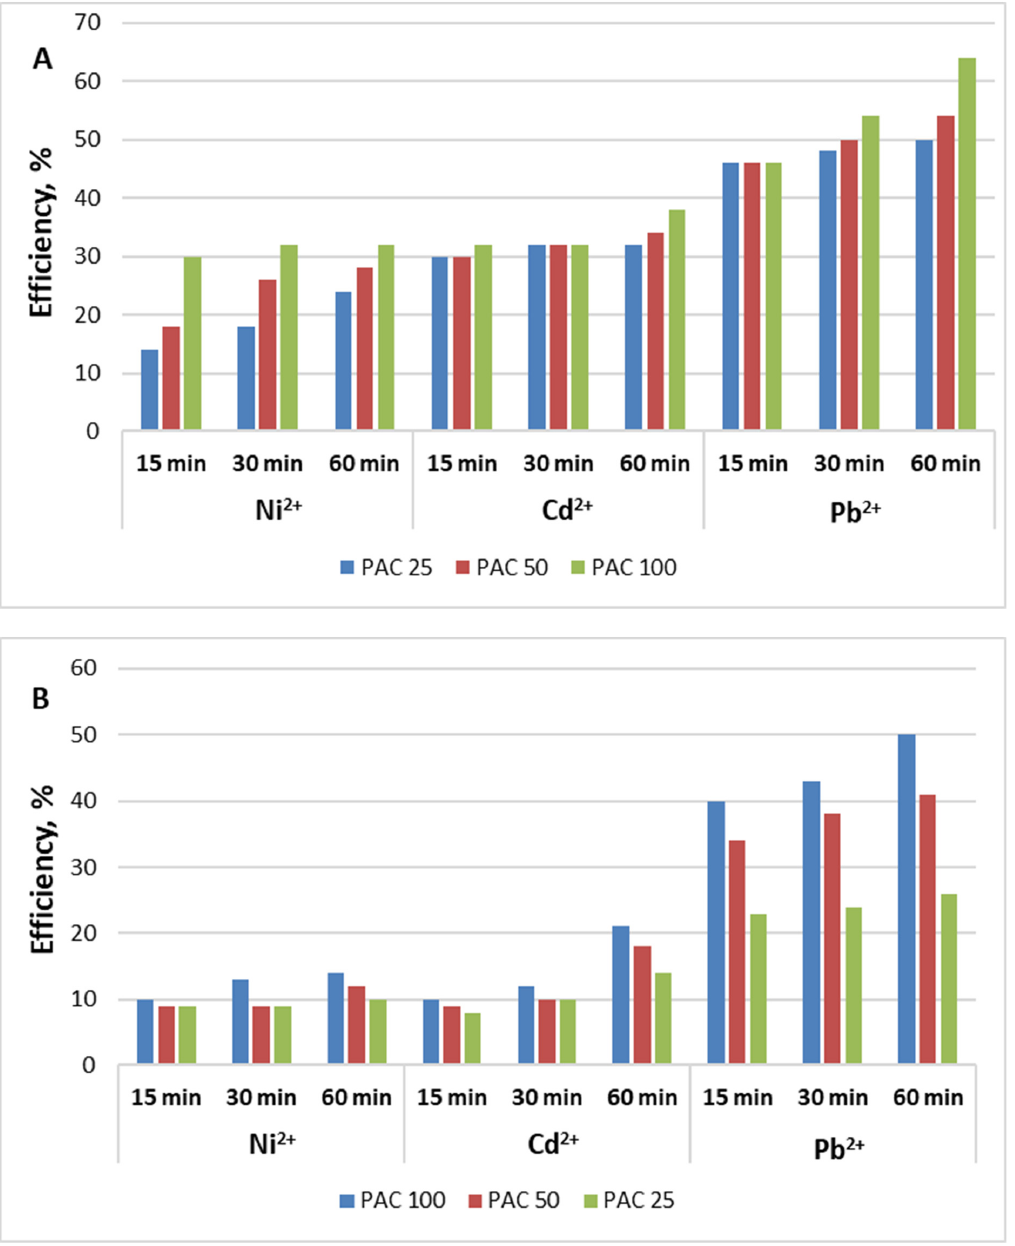
Figure 3. Efficiency of analysed metal ions removal from model water in the adsorption process with using powdered activated carbon (dose: 25, 50 and 100 mg/L), time of process 15, 30 and 60 min, initial concentration of heavy metal ions: ( A ) 0.5 mg/L and ( B ) 1.0 mg/L.